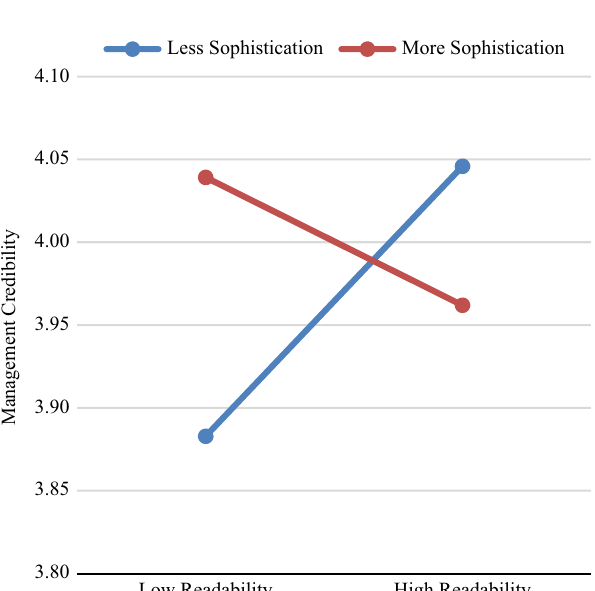
investors ’ perceptions of management credibility